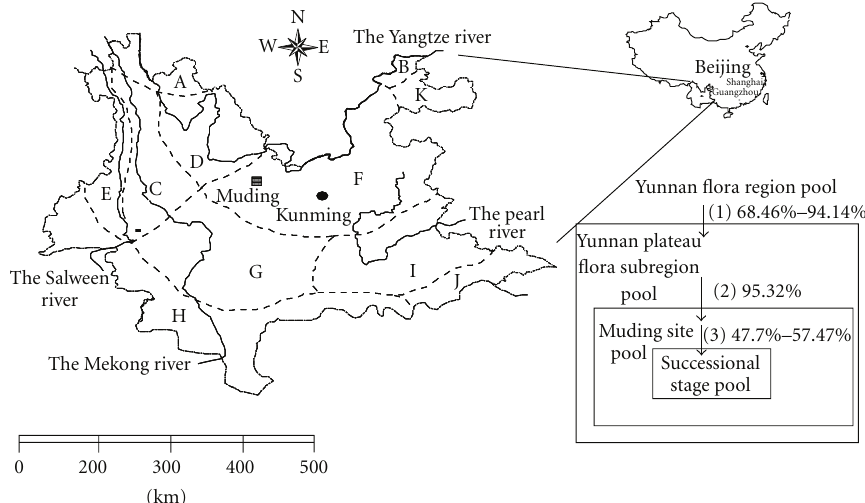
Figure 1: Map of the flora region of Yunnan province in China. On the map, all flora subregions are determined as scale-expanded communities. A: Kang-Tibet flora subregion; B: Big-small Liangshang flora subregion; C: Western Yunnan gorge flora subregion; D: Jingshajiang river flora subregion; E: Eastern-Himalaya flora subregion; F: Yunnan plateau flora subregion; G: Middle Liangcan-Honghe river flora subregion; H: Yunnan-Burma-Laos border flora subregion; I: Eastern-south Yunnan flora subregion; J: Yunnan-Viet Nam border flora subregion; K: Eastern Yunnan flora subregion. The hierarchical species pools and filters eliminating species from each are summarized in the bottom right-hand corner of the figure. (1) Filter between the Yunnan flora region pool and the 11 flora subregion pools. (2) Filter between Yunnan plateau flora subregion F and the Muding site pool (local pool). (3) Filter between the Muding local pool and successional stage pools. Percentage beside each arrow shows the filter ratio of species between neighboring pools.